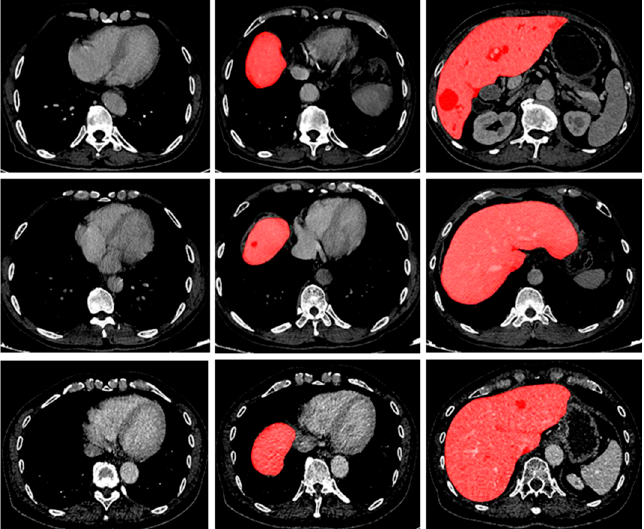
Figure 1. Examples of the imbalance between background voxels and target voxels in images. Each row shows a CT scan from individual patients. The read regions denote the liver.